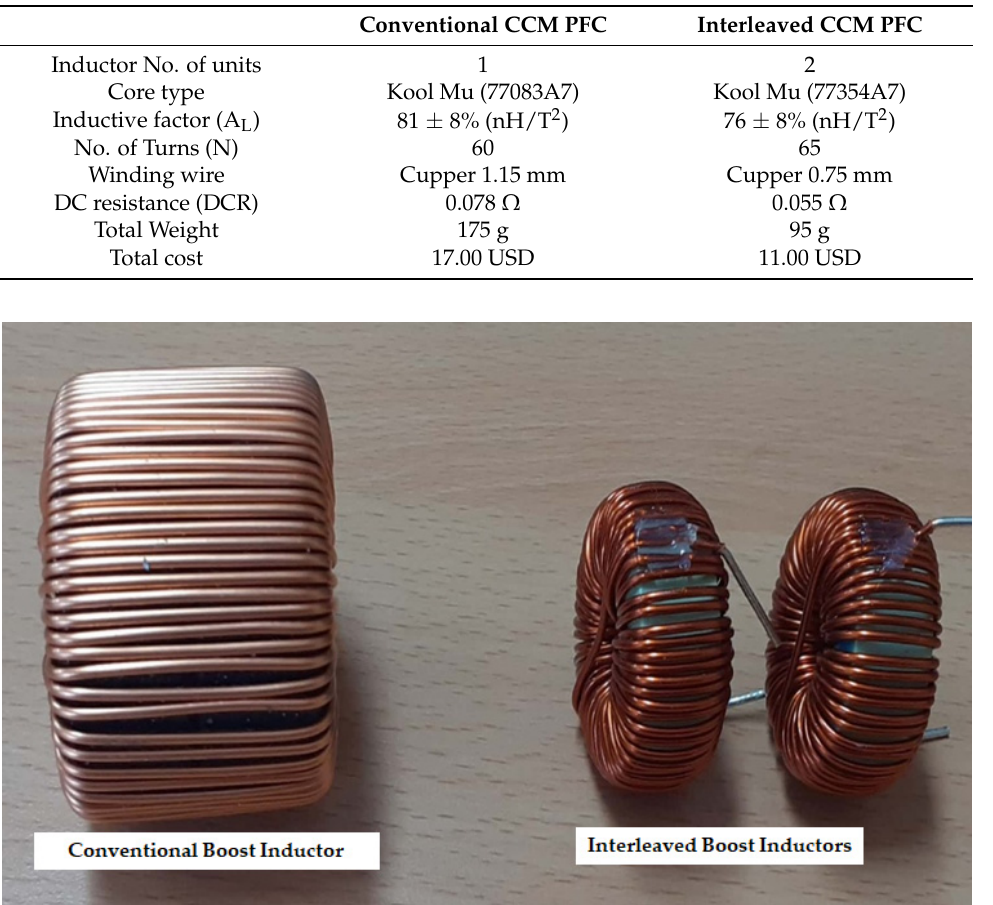
Table 2. Boost inductor specifications for the PFC (power factor correction) topologies. CCM (continues-current-conduction mode).